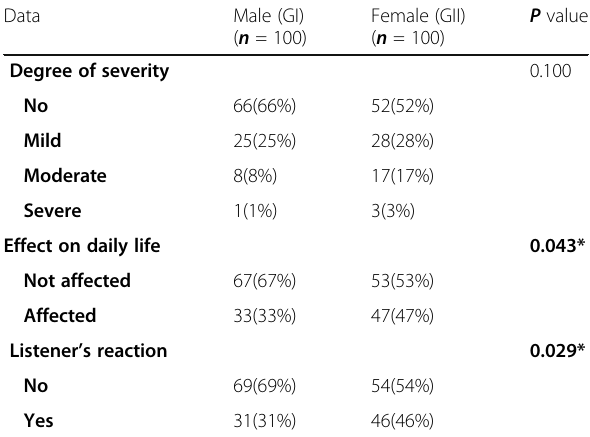
Table 5 Comparison between male and female teachers in the impact of complaint on teachers